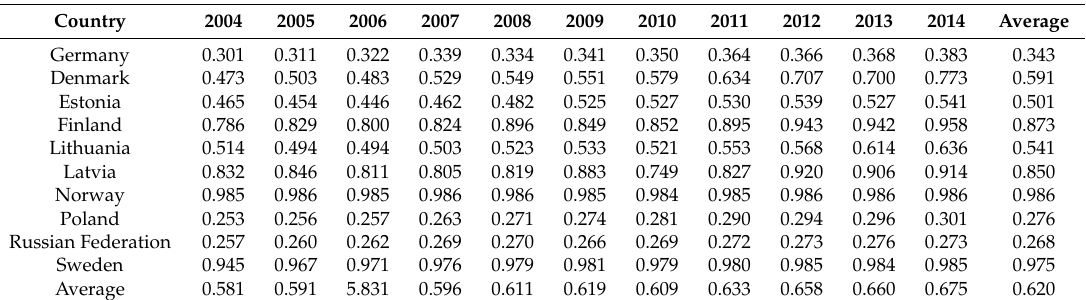
Table 3. Energy use efficiency scores of the 10 Baltic Sea countries between 2004 and 2014. Country